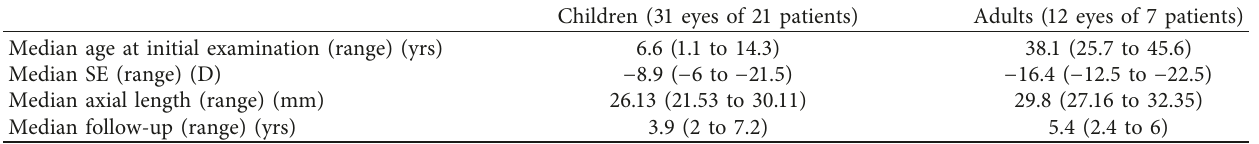
Table 1: Clinical characteristics of children and adults at the initial examination.